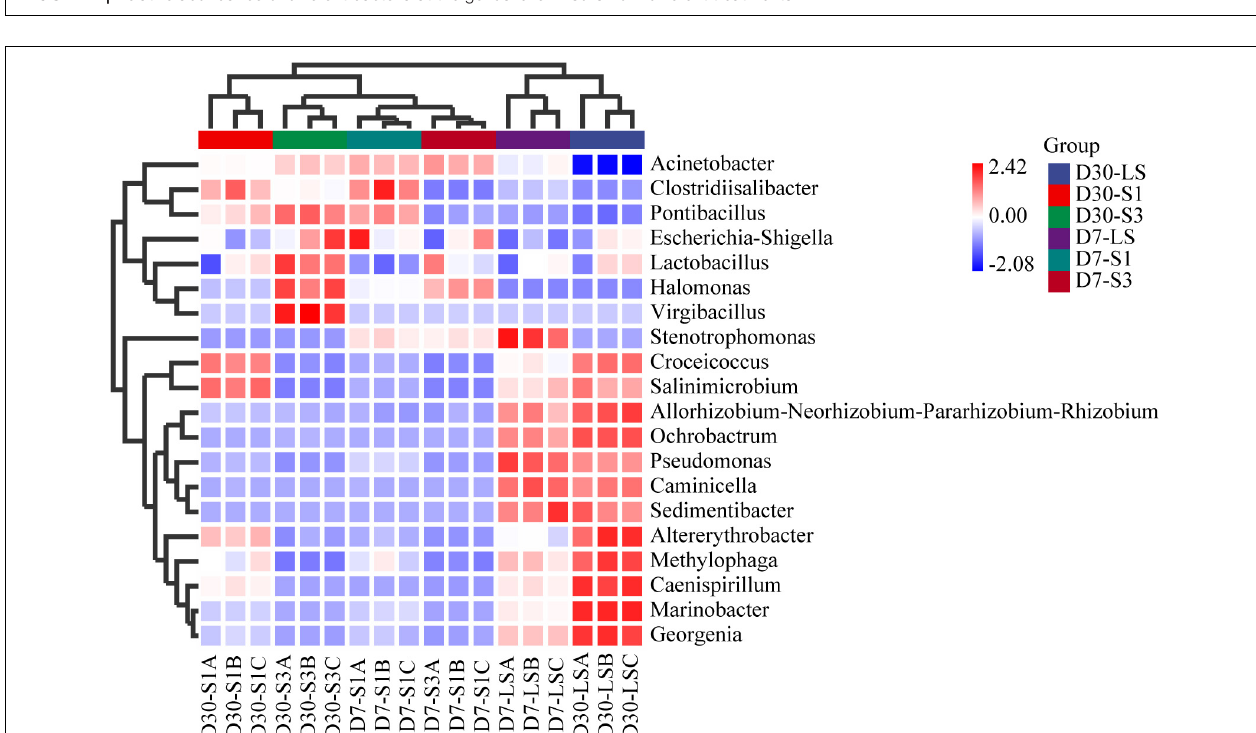
FIGURE 7 | Relative abundance of different bacteria at the genus level in soils from different treatments.